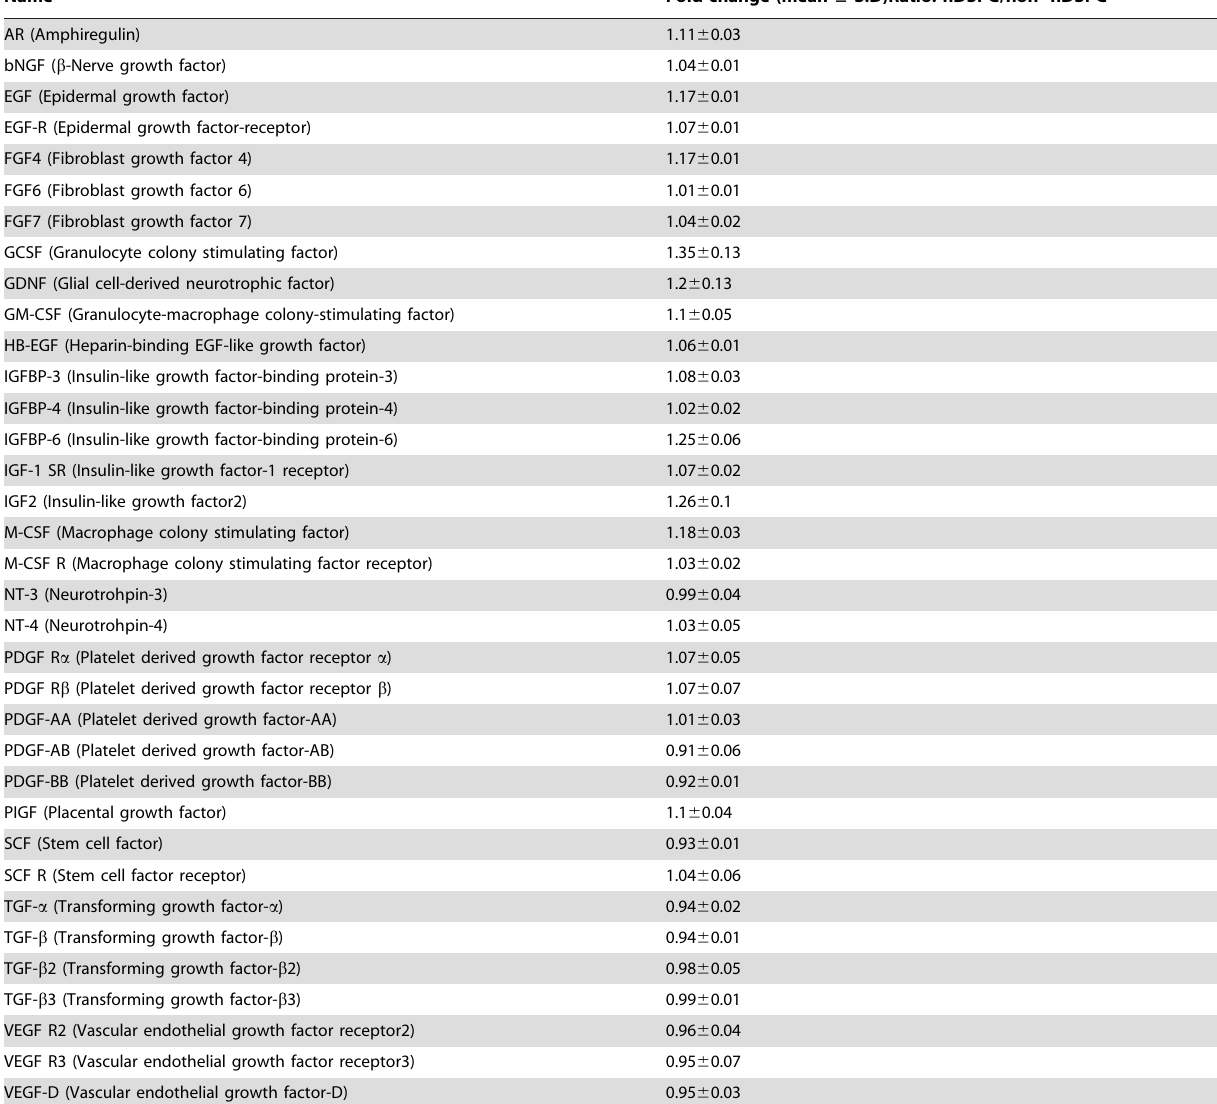
Table 1. Relative growth factor secretion analysis of hDSPC-CM.